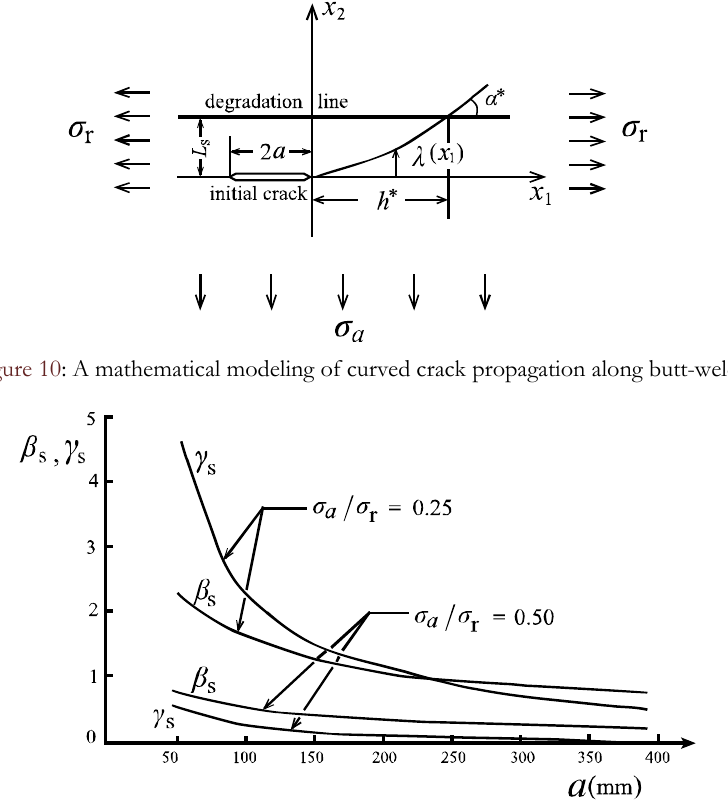
Figure 11: Crack path destabilizing factors * / α